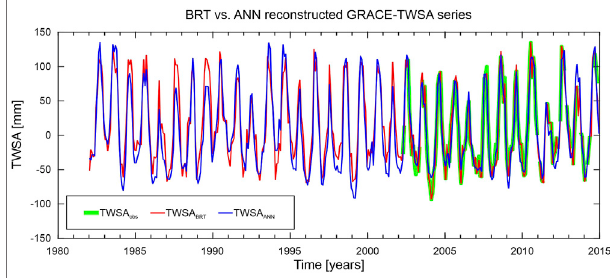
FIGURE 6 | Time series of TWSA predicted by the BRT and ANN (1982 – 2014) and those observed (April 2002 – December